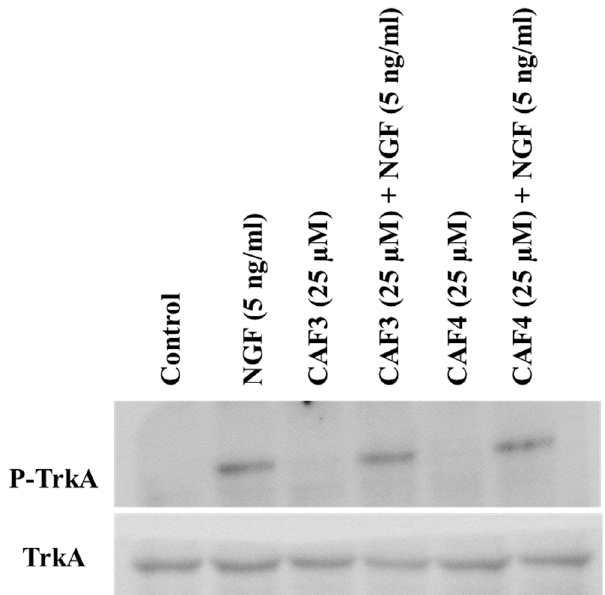
Figure 4. Assessment of TrkA phosphorylation in NIH/3T3 ‐ TrkA cells exposed to synthesized caffeate esters. NIH/3T3 ‐ TrkA cells were seeded in 12 ‐ well plates in Dulbecco’s modified Eagle’s